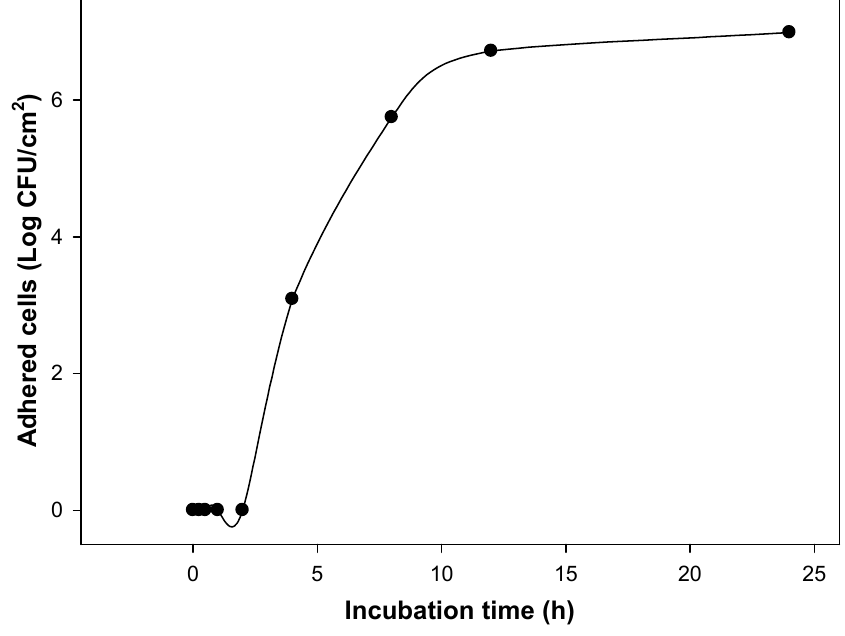
Figure 1. Uropathogenic E. coli adhesion on silicone catheter surfaces for 24 h at 37 °C. A significant effect of the incubation time on the cellular adhesion was found ( p ≤ 0.05). Means for three independent experiments. The initial inoculum added to the system was 3 Log CFU/mL.